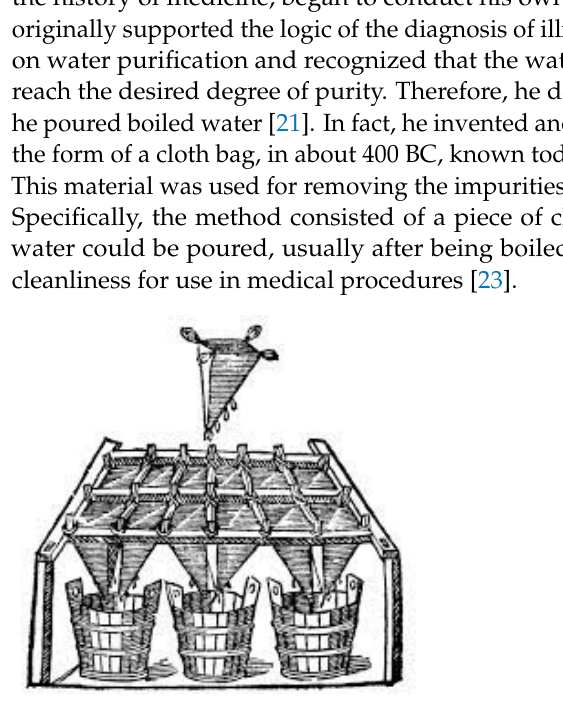
Figure 4. A Brief History of the Evolution of Water [1] .